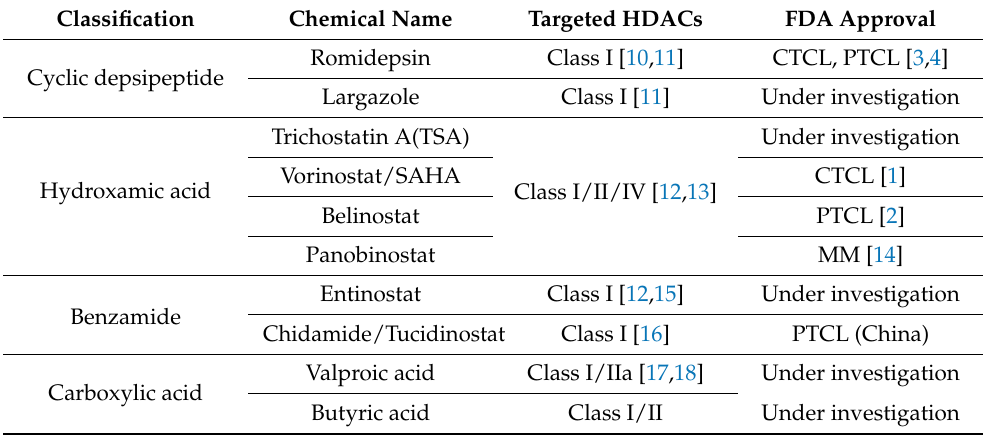
Table 1. Classification, targeting selectivity (HDAC class), and applications in cancer therapy for the most-studied HDAC inhibitors.